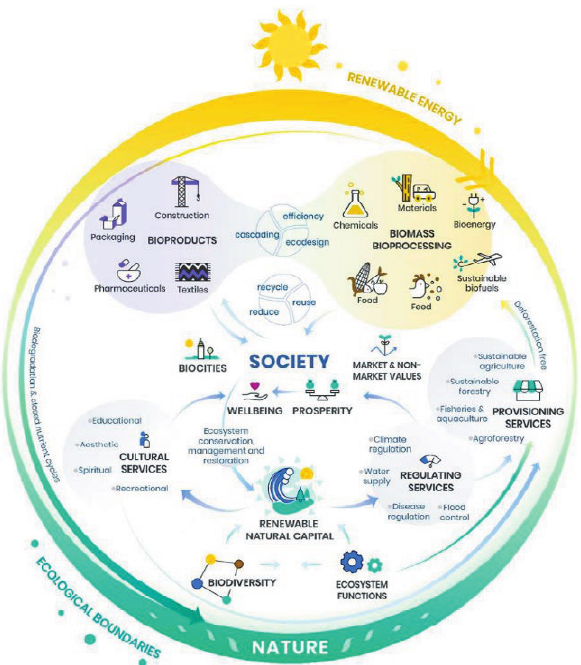
Figure 2 Circular Bioeconomy and wellbeing. Source: European Forest